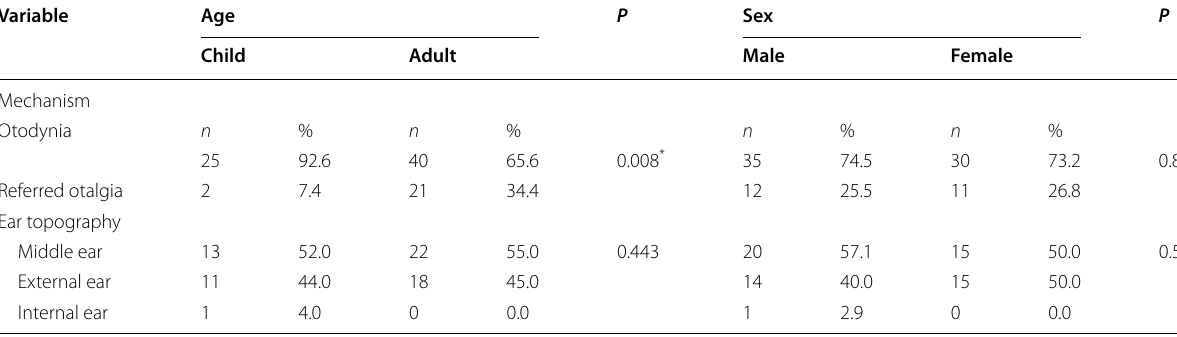
Table 4 Relationship between the causal mechanism of otalgia to age group and